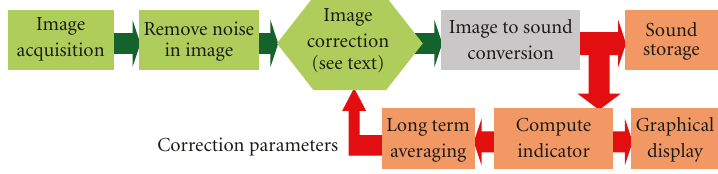
Figure 17: Closed-loop